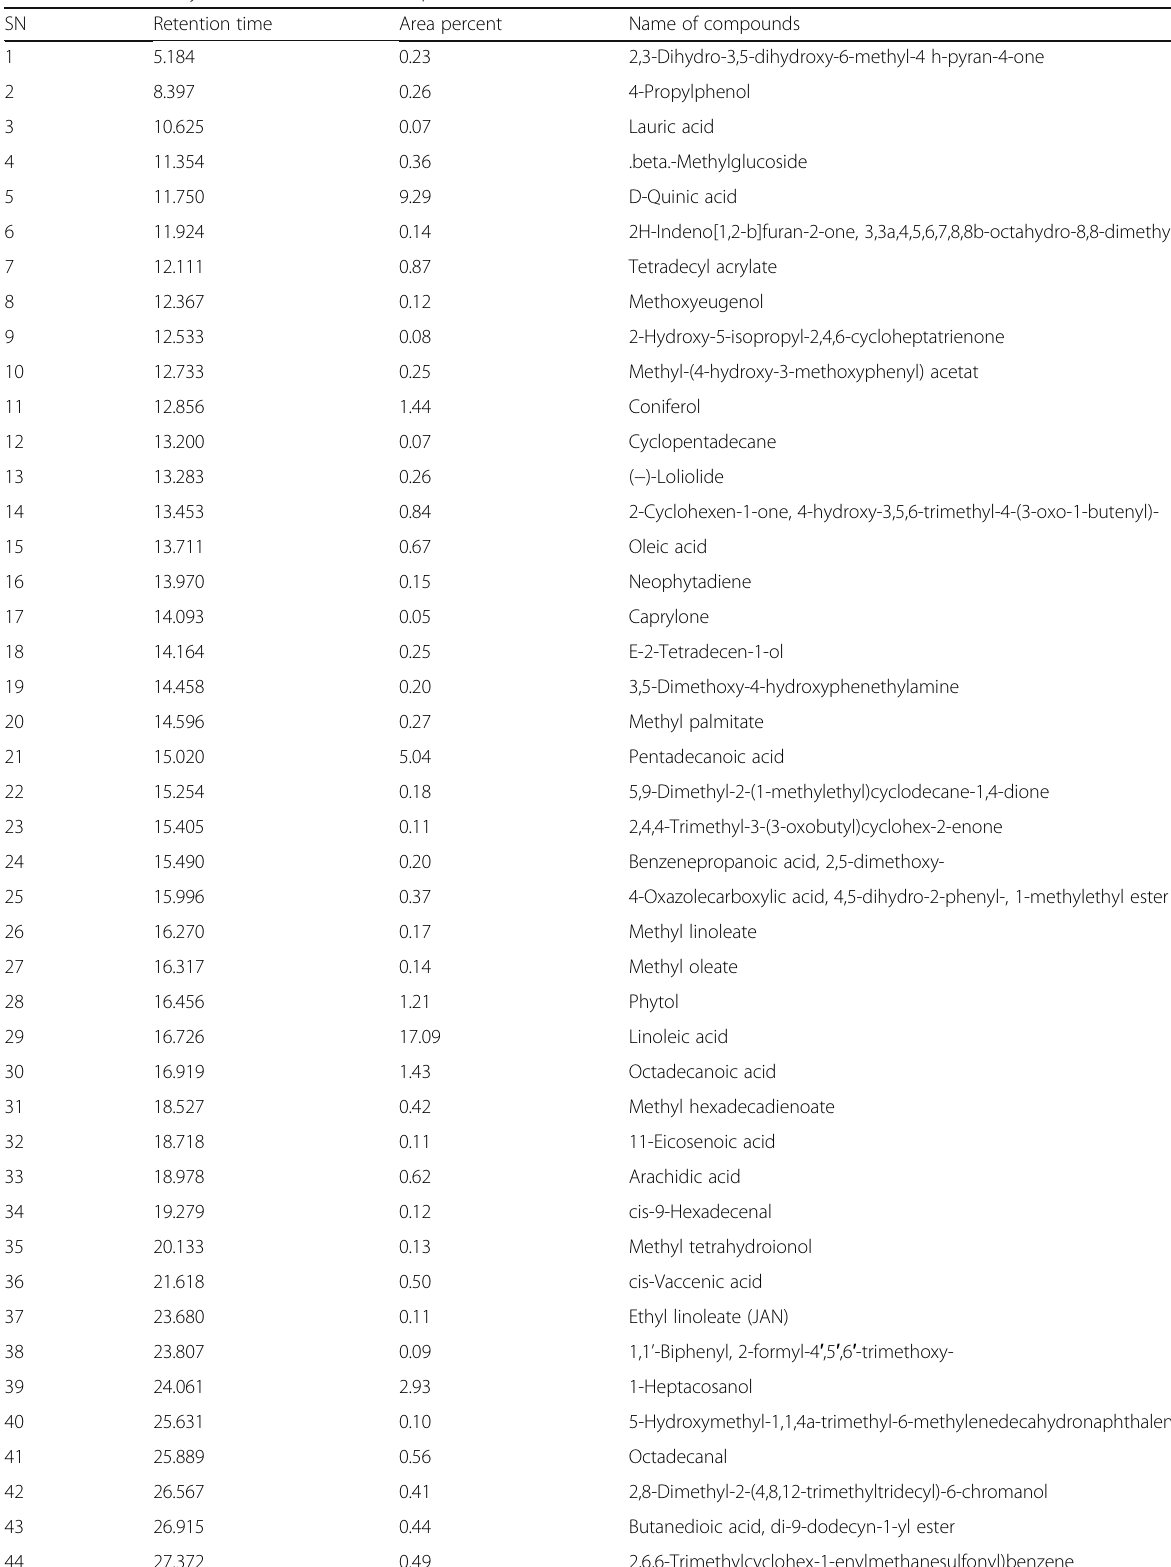
Table 2 GC-MS analysis of Quercus leucotrichophora (Leaves) extract SN Retention time Area